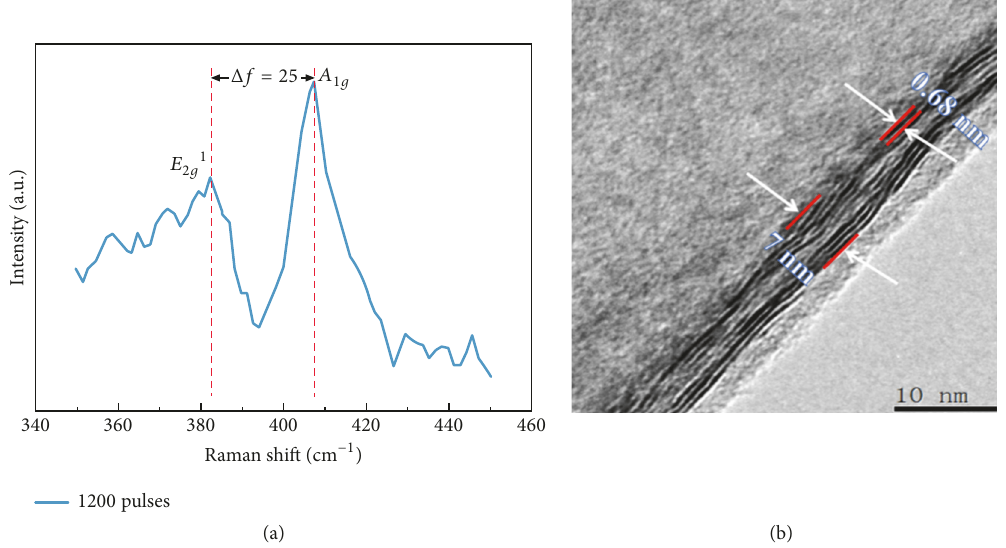
Figure 2: (a) Raman image of MoS 2 films. The distance between 𝐸 2𝑔1 and 𝐴 1𝑔 is 25 cm −1 . (b) Cross-sectional TEM image of few-layer MoS 2 film.